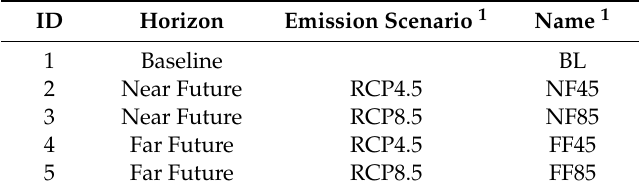
Table 3. Summary table of the scenarios studied for the case study